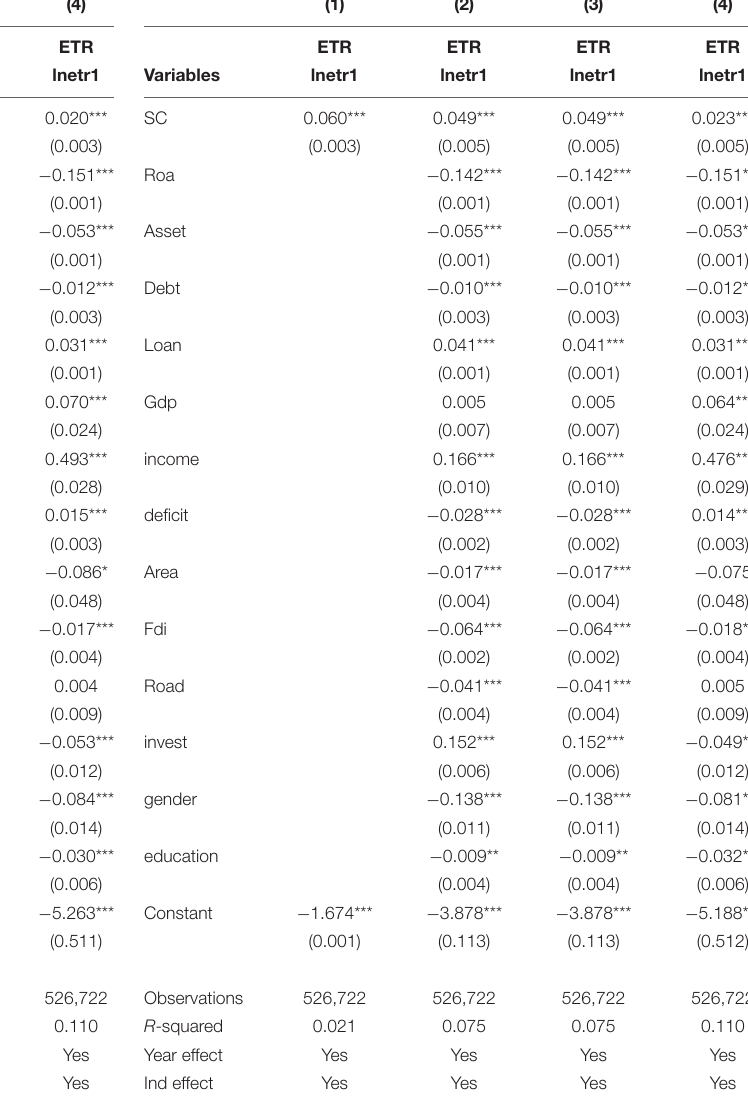
TABLE 3 | Impact of official assignment on the effective corporate tax rate. TABLE 4 | Impact of social capital of officials on the ETR of